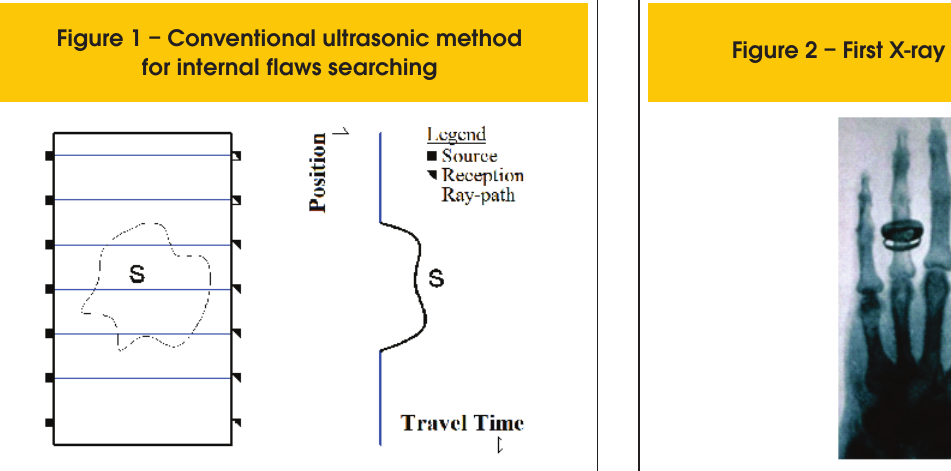
Figure 2 – First X-ray image (Haase